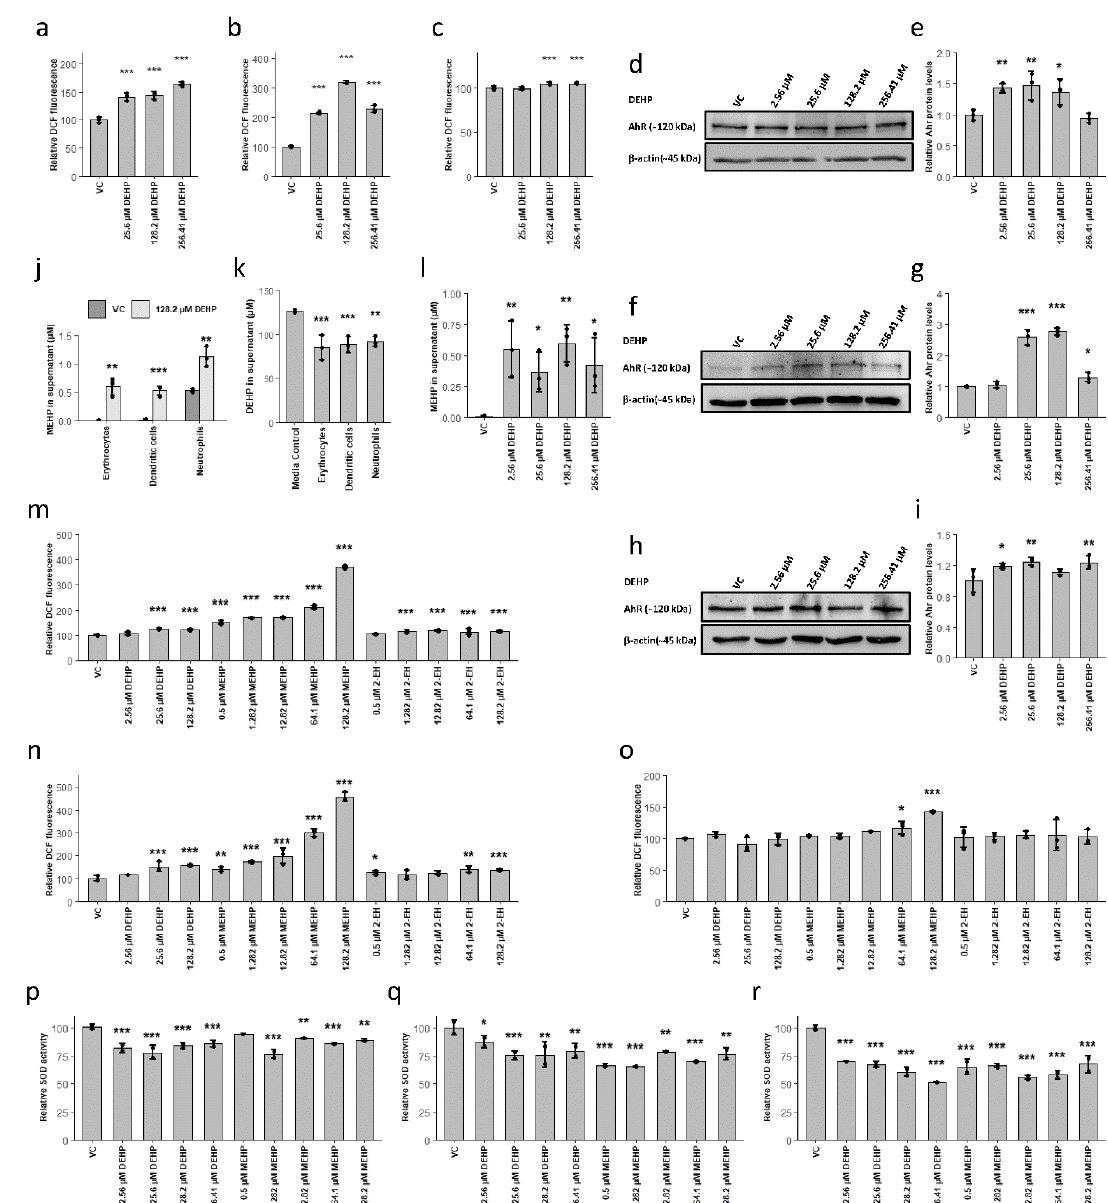
Figure 3. The DEHP metabolite, MEHP, reduces SOD activity and increases ROS at environmentally relevant concentrations. ( a – c ) Relative fluorescence (DCF) after DEHP treatment of erythrocytes for 4 h ( a ), dendritic cells for 3 d ( b ), and neutrophils for 3 d ( c ). ( d – i ) Relative expression of aryl hydrocarbon receptor (AhR) protein in erythrocytes ( d , e ), dendritic cells ( f , g ), and neutrophils ( h , i ) in response to increasing concentrations of DEHP. ( j – l ) Concentrations of MEHP ( j ) and DEHP ( k ) detected in cell culture supernatants after treatment with 128.2 µ M DEHP and other concentrations for 48 h ( l ). ( m – o ) Relative fluorescence (DCF) after MEHP or 2-EH treatment of erythrocytes for 4 h ( m ), dendritic cells for 3 d ( n ), and neutrophils for 3 d ( o ). ( p – r ) Relative SOD activity after DEHP or MEHP treatment of erythrocytes for 2 d ( p ), dendritic cells for 3 d ( q ), and neutrophils for 3 d ( r ). Data are presented as mean ± standard error of the mean (SEM); individual replicates are visualized as black dots in bar charts in case of n = 3. Significance was determined by one-way ANOVA (* p < 0.05; ** p < 0.01; *** p < 0.001).